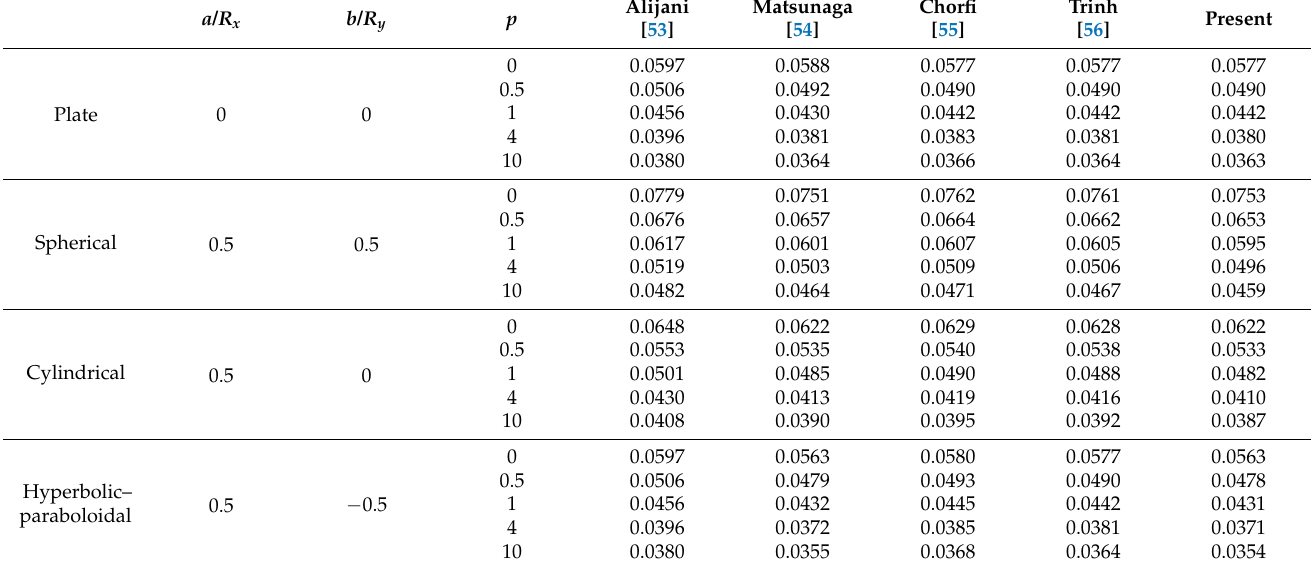
Table 4. Comparison of the natural frequency parameter Al/Al 2 O 3 functionally graded square plates and doubly curved shells ( a = b = 10 h , m = n =